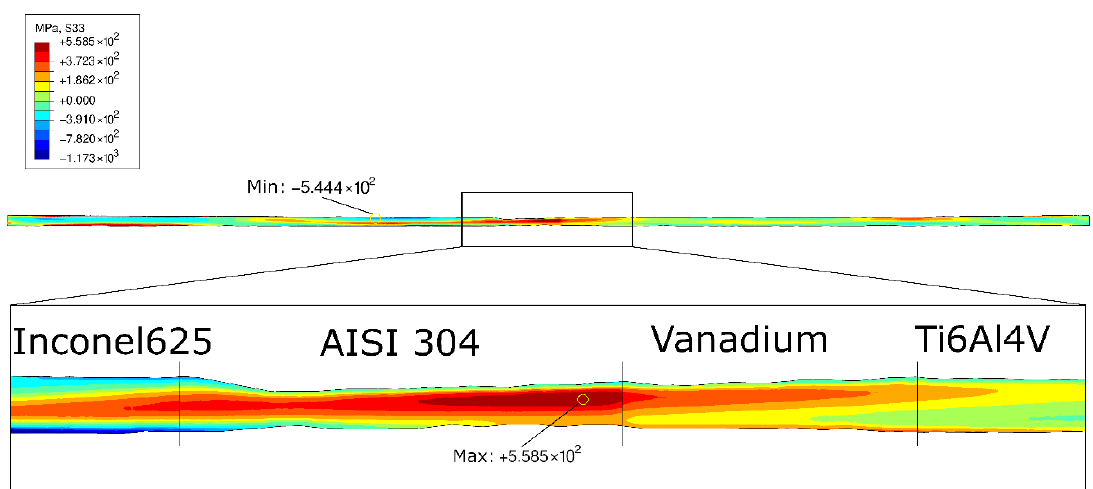
Figure 7. Longitudinal residual stress map (stresses are in MPa). Table 5. Coefficient of thermal expansion of the materials composing the welded plates